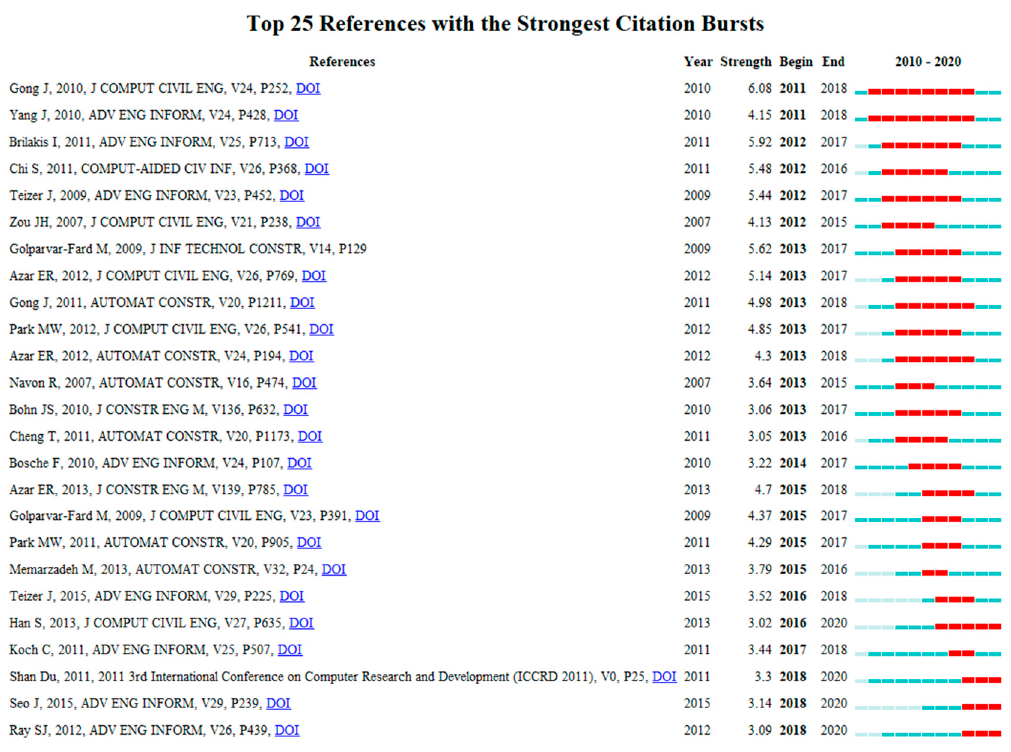
Figure 4. Strong citation burst references.